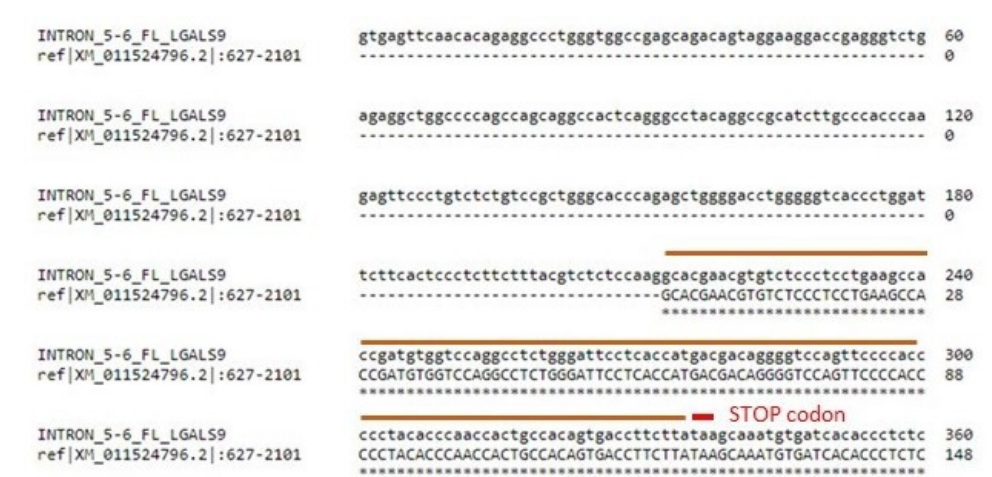
Figure 7. Partial alignment (Clustal Omega) of intron 5–6 from FL LGALS9 (sequence obtained from Ensembl, ID ENSG00000168961, transcript ID of FL ENST 00000395473.7) and exon 6 ′ from the X5 variant (obtained from the NCBI gene database). Intron 5–6 of FL is 1693 NTs long, while exon 6 ′ is 1475 NTs. Exon 6 ′ is almost completely identical intron 5–6, except for the first 212 NTs and the last 6 NTSs, which are probably spliced out in X5. The TAA stop codon (red) probably leads to the truncation of X5. For further details, see additional comparison and alignment analyses in Figures S4-S5 (Supplementary data).